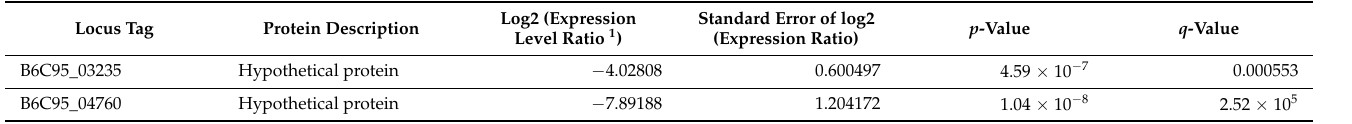
Table 4. Differential expression of S. epidermidis biofilms under anaerobic conditions in the presence of CNP, revealed via